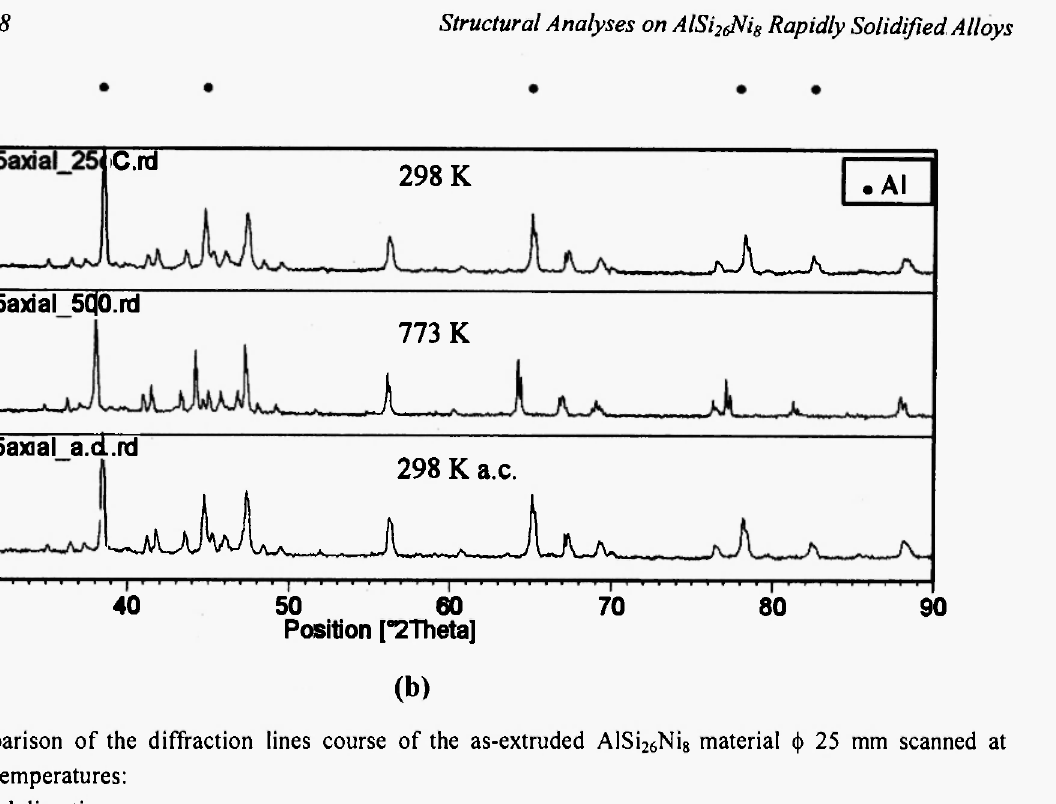
Fig. 7a, b: Comparison of the diffraction lines course of the as-extruded AISi 26 Ni 8 material φ 25 mm scanned at different